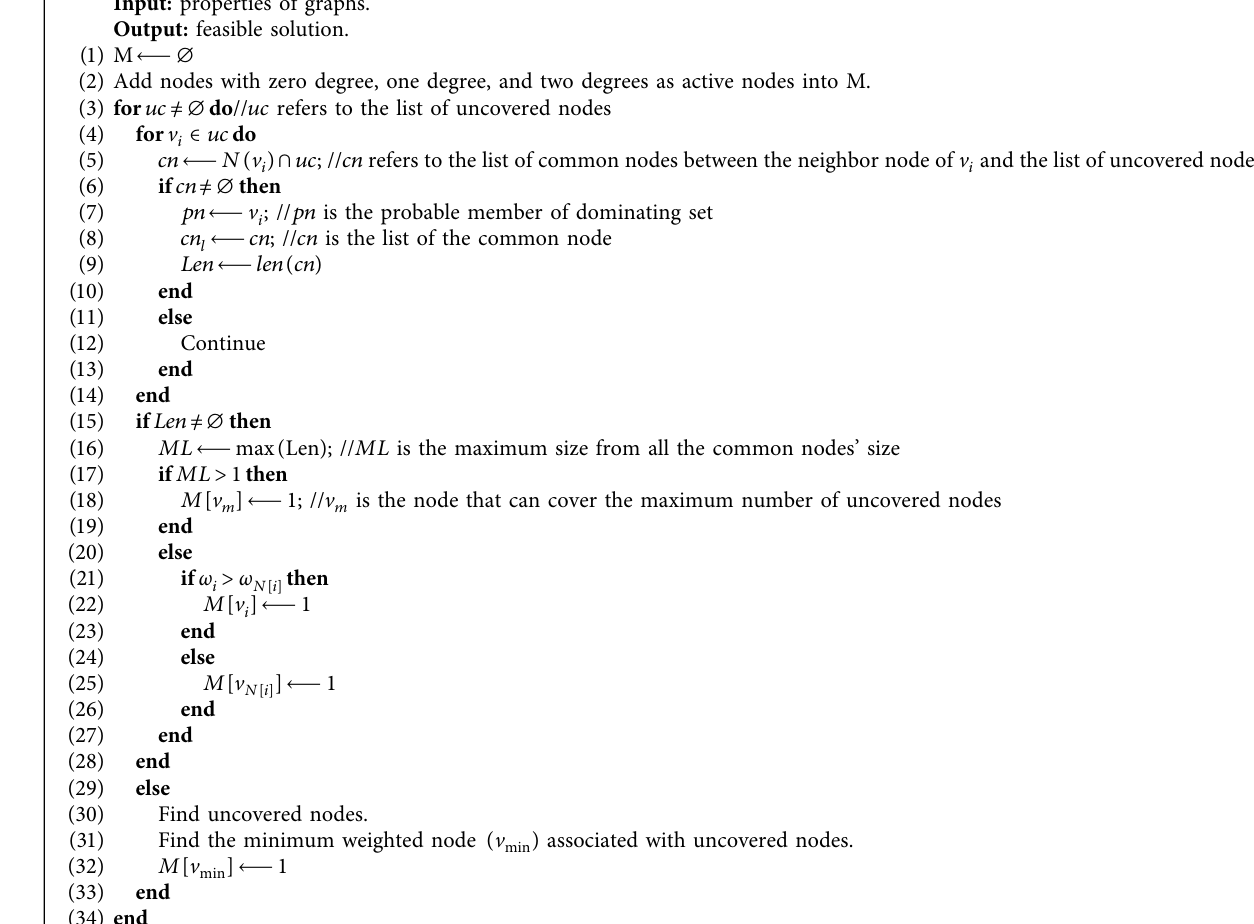
A LGORITHM 2: Te second stage of population